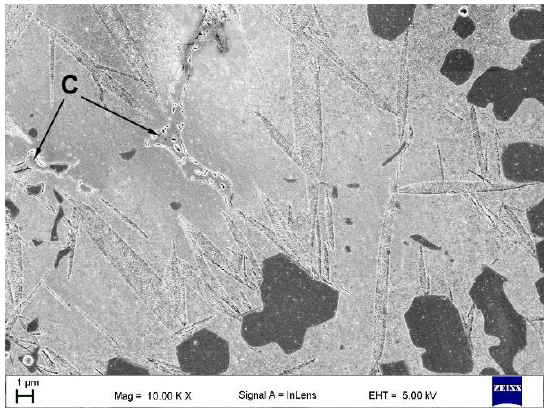
Figure 9. In-lens SEM micrograph taken from the mid-section of the TRM (Table 3) showing the eutectic-like structures (C) as a result of the last solidification stages.